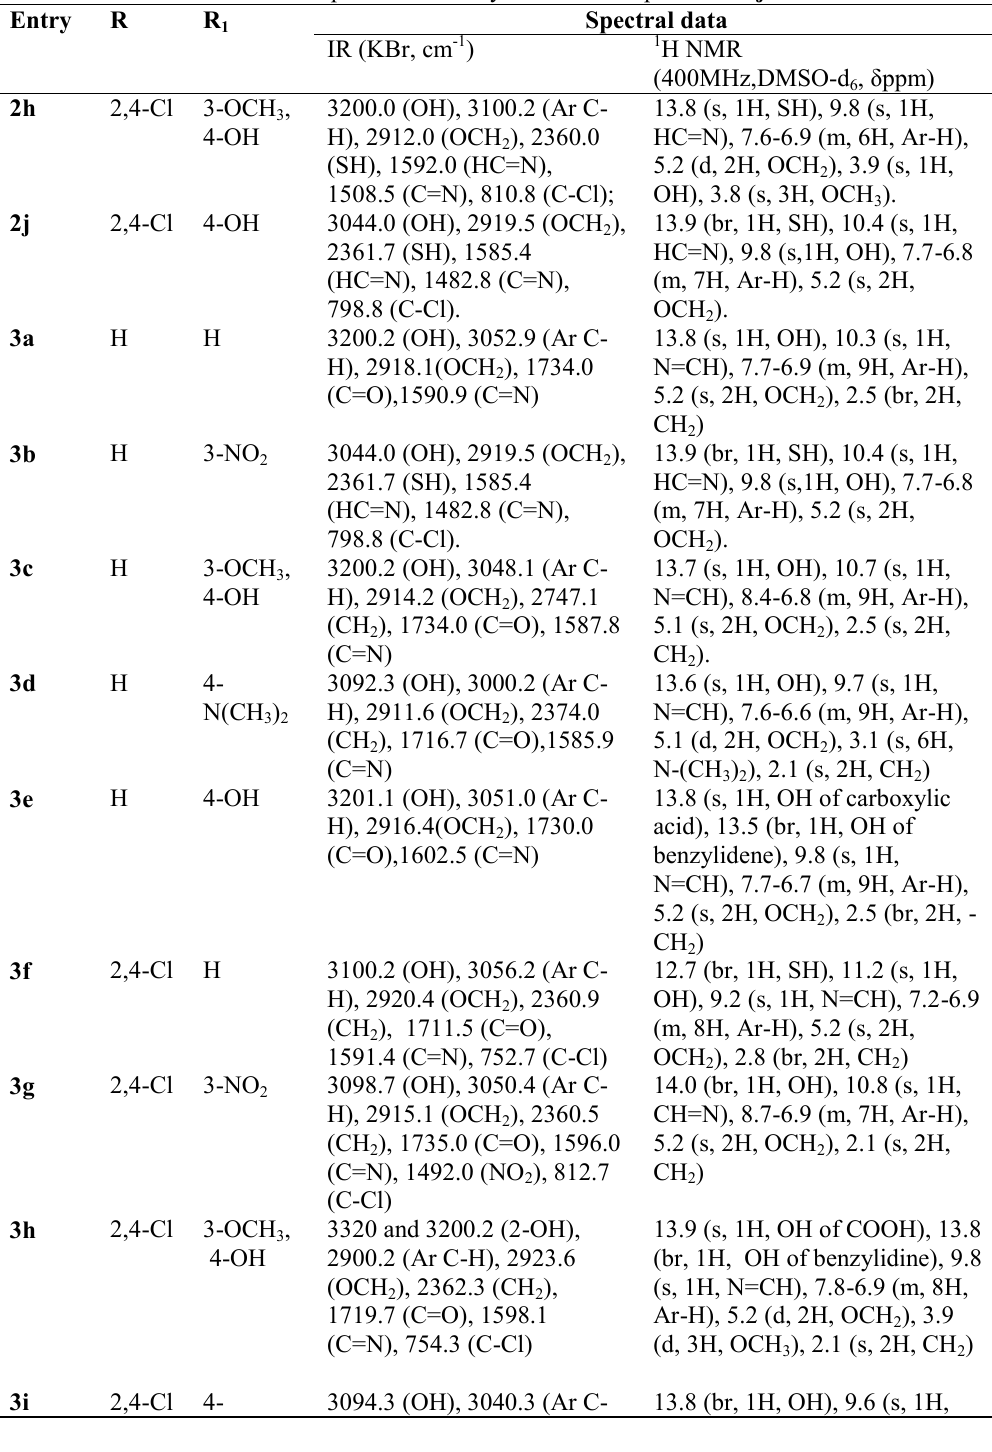
Table 1. Spectral data of synthesised compounds 3a-j